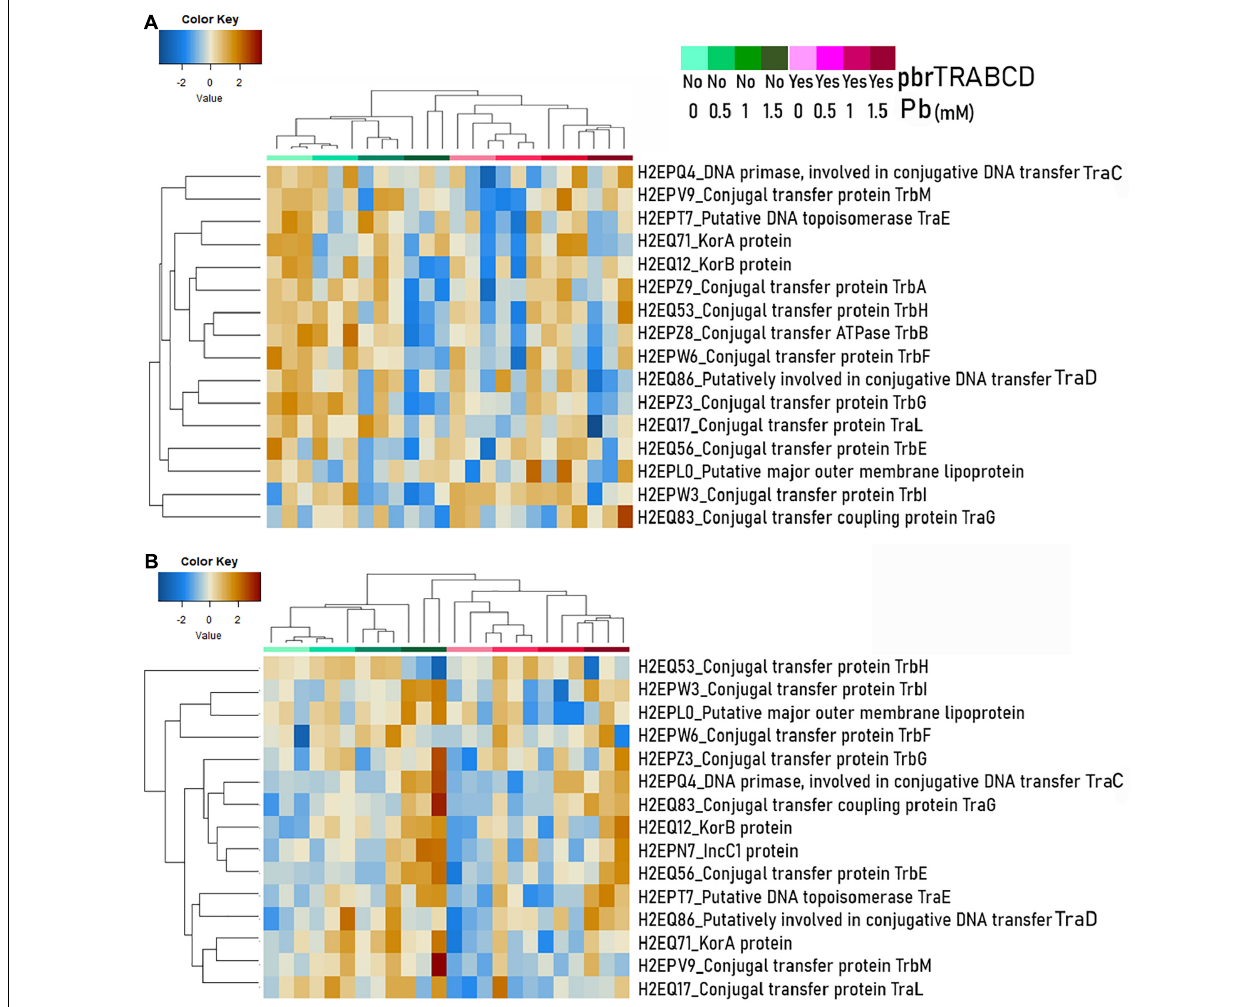
FIGURE 7 | Abundance of conjugation-associated proteins (two or more identified peptides) encoded by the pKJK5 plasmid [normalization on the summed area of all peptides for each sample and by cell proportion of plasmid carrier (donor + transconjugant) (see Supplementary Table 8 )] displayed on a heat map (Euclidean distance and average clustering) as extracted from two-member communities using either Variovorax paradoxus B4 (A) or Delftia acidovorans SPH-1 (B) as the plasmid